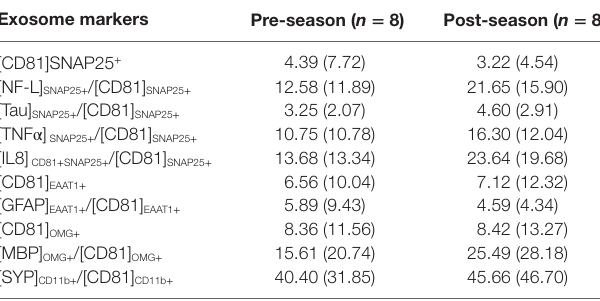
TaBle 2 | Changes in exosome markers between pre- and post-season. exosome markers Pre-season ( n = 8)